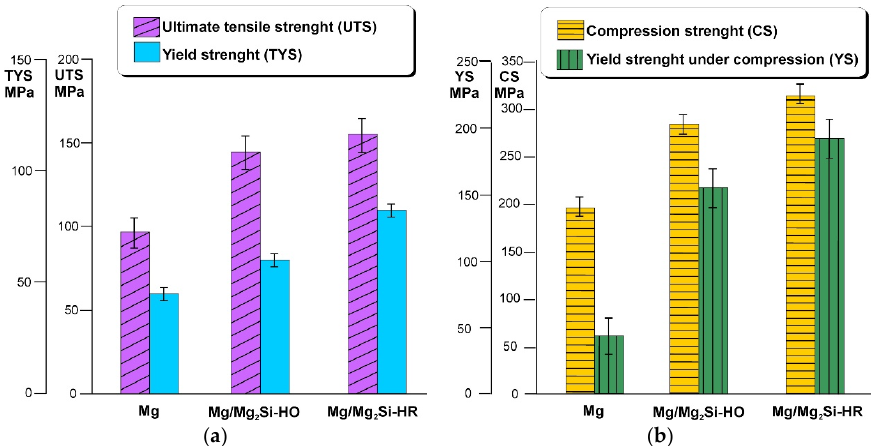
Figure 8. Average values of ultimate tensile strength (UTS) and yield strength (TYS) ( a ), compression strength (CS) and yield strength under compression (YS) ( b ) for Mg / Mg 2 Si–HO and Mg / Mg 2 Si–HR composites comprised with technically pure magnesium (with scatter of